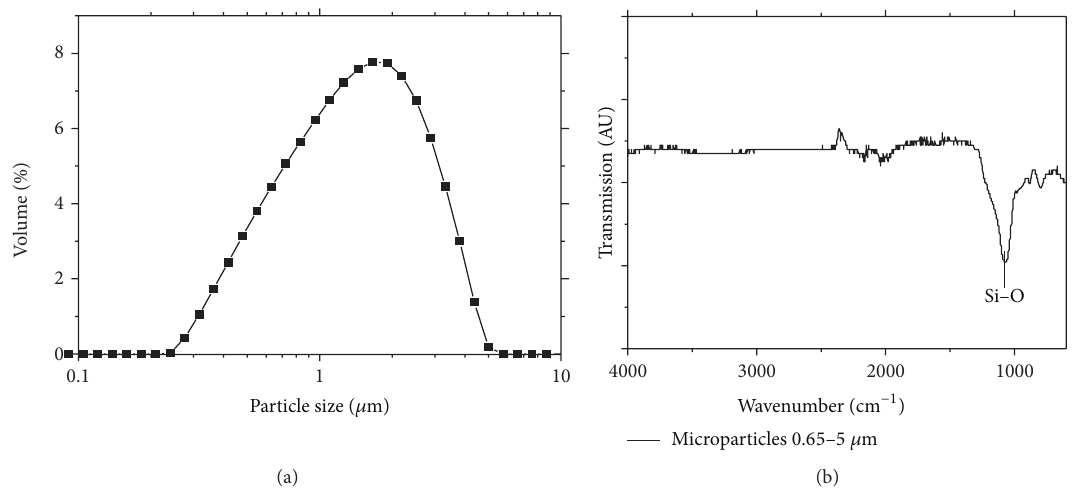
Figure 1: (a) Particle size distribution of MSMPs materials (nanosizer measurement) after being milled and sieved. (b) FTIR spectra of the porous silicon layers on a wafer after thermal oxidation